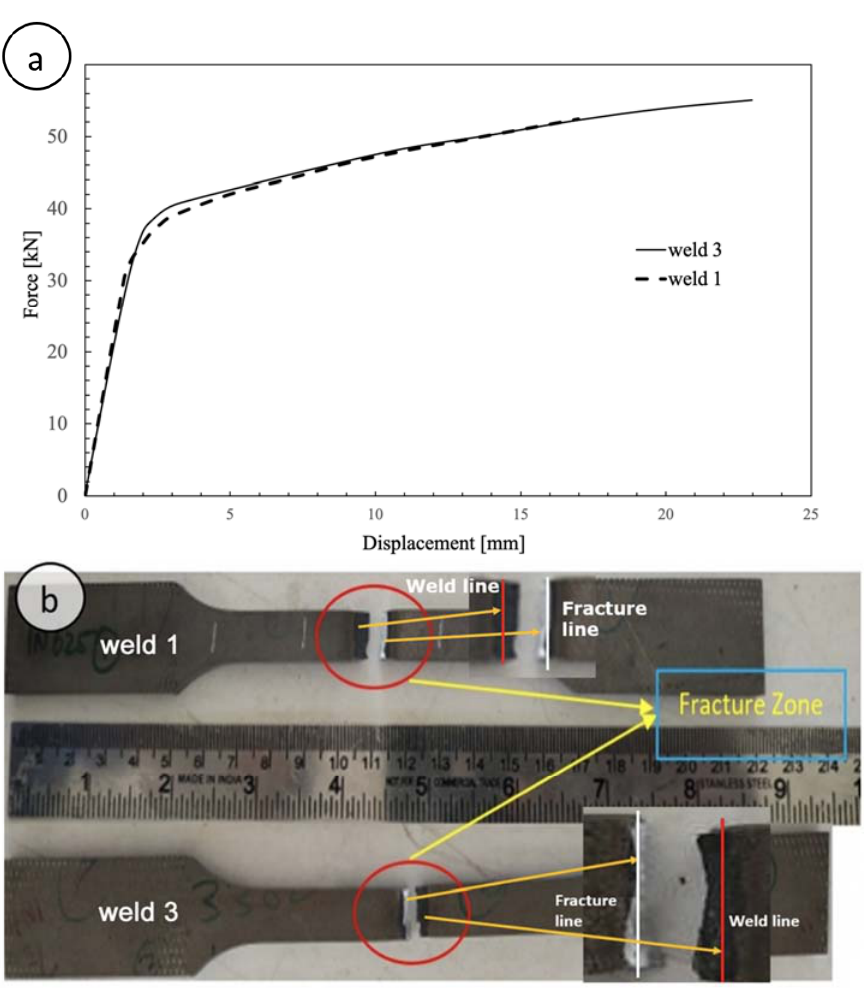
Figure 12. Tensile tests results: ( a ) UTS and YS, ( b ) failure location.